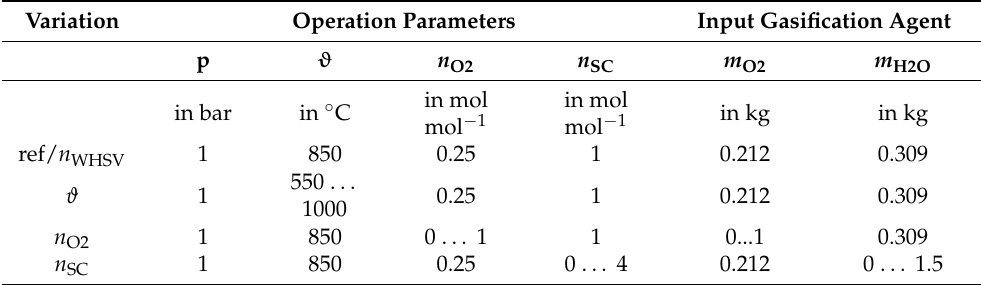
Table 6. Gasification agent input masses and operation parameters for FactSage ® equilibrium calculation for gasification of 1 kg as used sewage